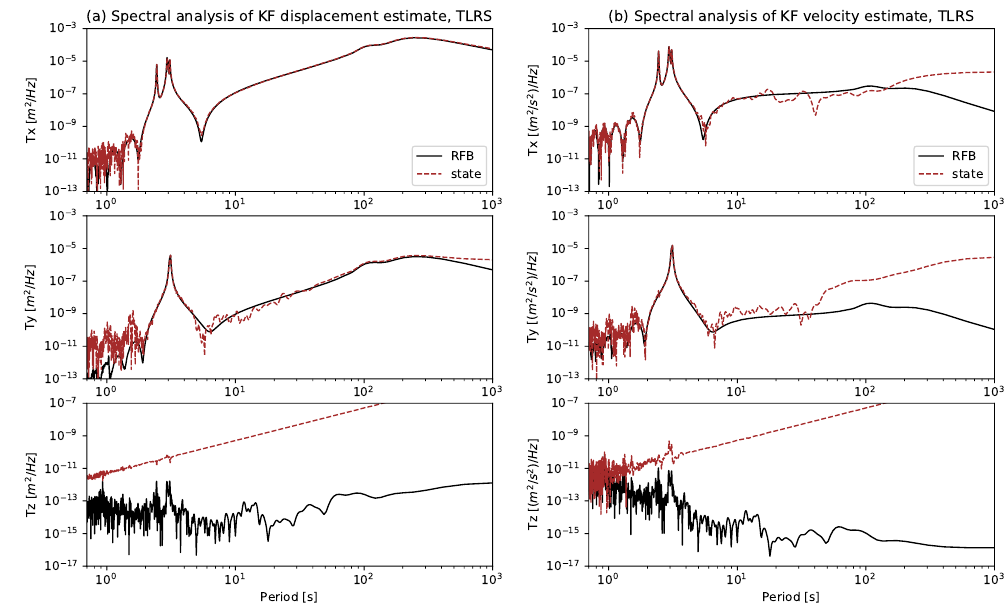
Figure A2. The robot feedback (RFB) is plotted in black and the KF estimate (state) is plotted in brown for the TLRS experiment. The ( a ) shows the KF displacement estimate and ( b ) shows the KF velocity